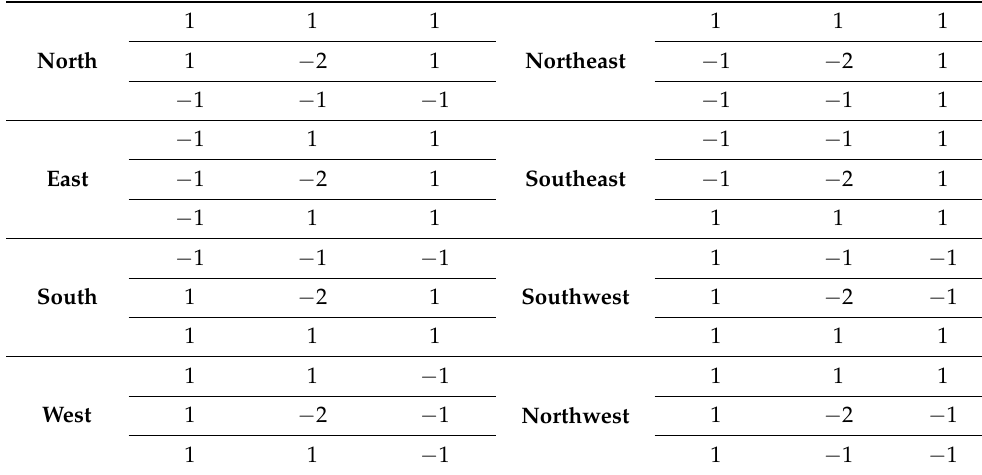
Table 2. Directional filtering of the compass with their associated coefficient.